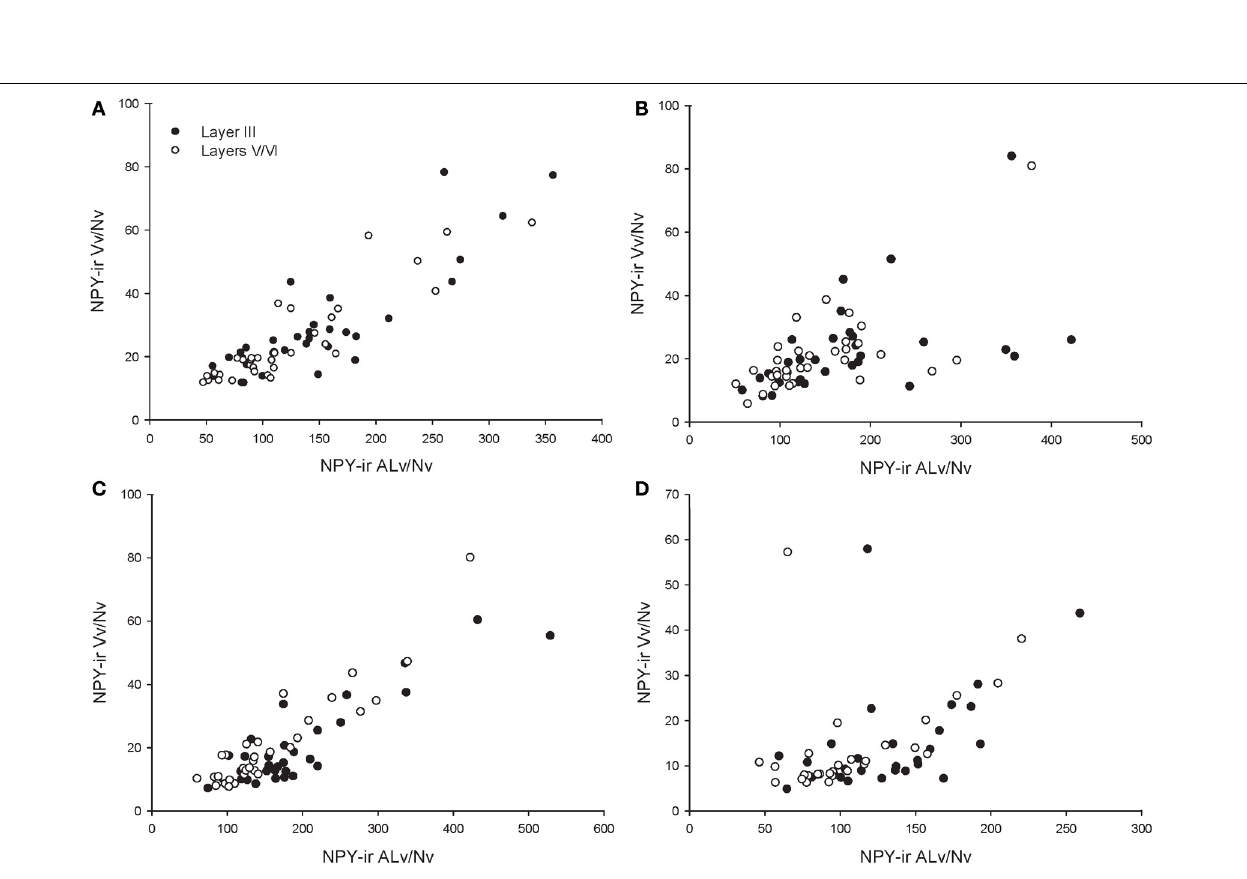
Frontiers in Human Neuroscience